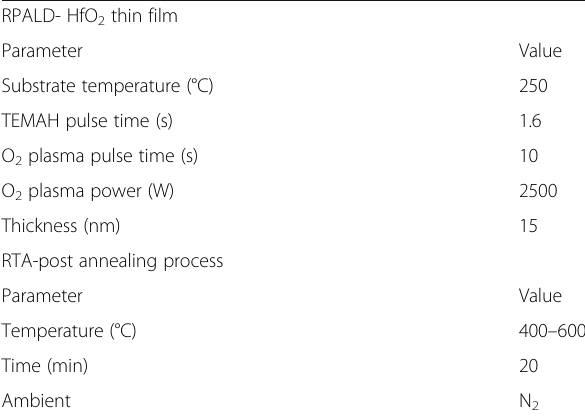
Table 1 RPALD HfO 2 deposition